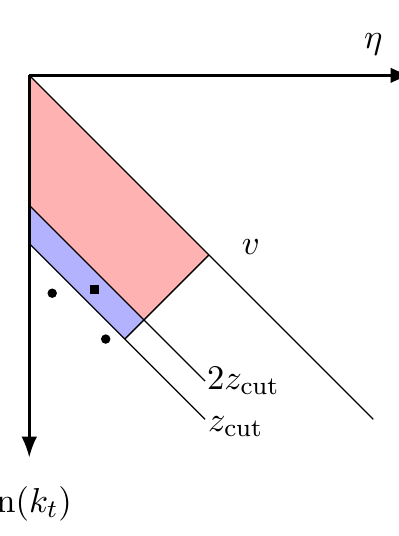
Figure 5. Lund diagram showing the region of phase space responsible for the correlated clustering correction in blue, and in red the vetoed phase space responsible for the Sudakov factor. The black dots depict two correlated emissions, which, due to their separation in angle are clustered into different C/A branches, giving rise to the clustering correction. The black square represents the parent of these two